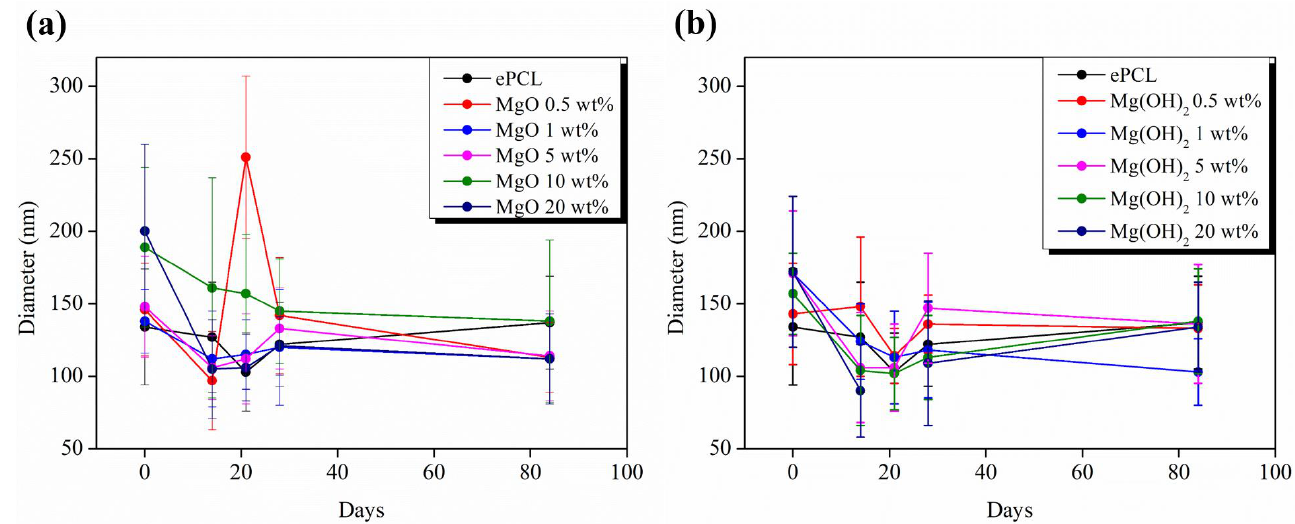
Figure 5. Variation of the electrospun fibers diameters at different days of degradation in PBS for: ( a ) ePCL reinforced with MgO NPs, ( b ) ePCL reinforced with Mg(OH) 2 NPs. For ePCL (black dots), no variations were observed in the diameter values during the first 84 days. ePCL presented an average diameter of 134 ± 40 nm at T0 and 137 ± 32 nm